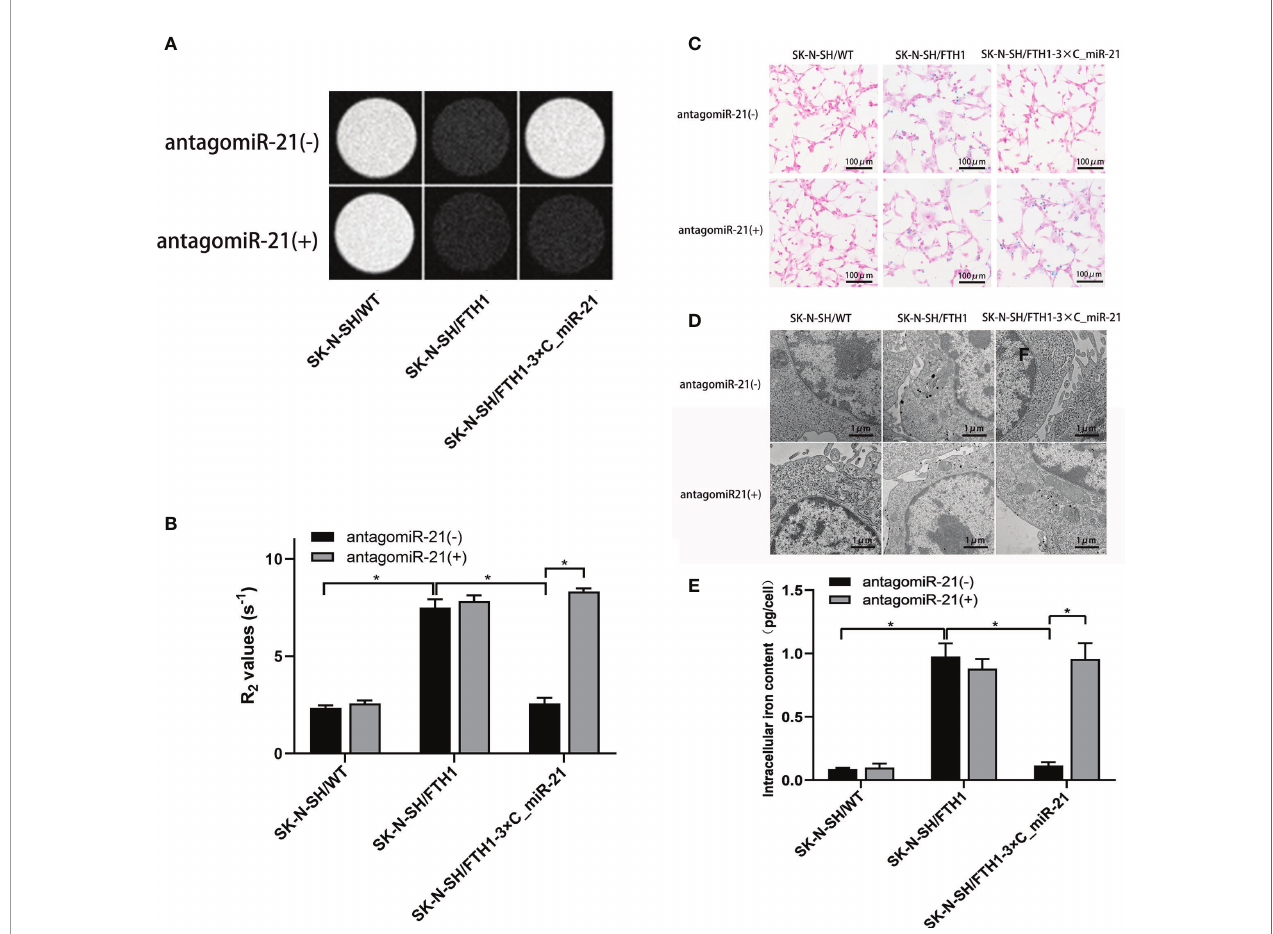
FIGURE 5 | Cellular MRI and intracellular iron detection. MRI imaging shows a signi fi cant T2WI signal reduction (A) and R2 value increase (B) in the SK-N-SH/FTH1- 3×C_miR-21 cells after antagomiR-21 transfection compared with that prior to antagomiR-21 treatment. In the SK-N-SH/WT and SK-N-SH/FTH1 cells, however, there were no differences in the MRI signals or R2 values before and after antagomiR-21 treatment. The Prussian blue staining (C) and TEM (D) results revealed that before antagomiR-21 transfection, large amounts of iron particles were detected in the cytoplasm of only SK-N-SH/FTH1 cells, while iron accumulation was not observed in SK-N-SH/WT or SK-N-SH/FTH1-3×C_miR-21 cells. After antagomiR-21 treatment, SK-N-SH/FTH1-3×C_miR-21 cells exhibited obvious iron accumulation compared with that prior to antagomiR-21 treatment. In the other two groups of cells, however, there was almost no change in the iron accumulation before and after antagomiR-21 treatment. Further iron content quanti fi cation (E) shows the same results as observed in Prussian blue staining and TEM. Three independent experiments were performed. * indicates P <